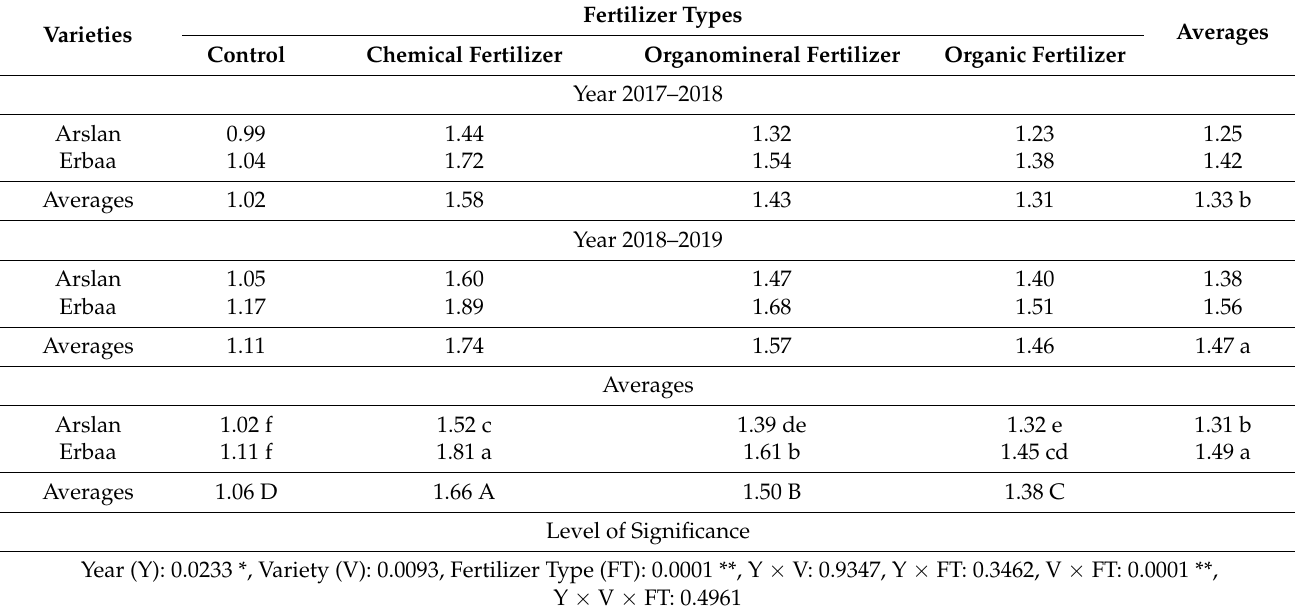
Table 7. The effect of fertilizer types on seed yield of coriander varieties (t ha − 1 ) 1 .